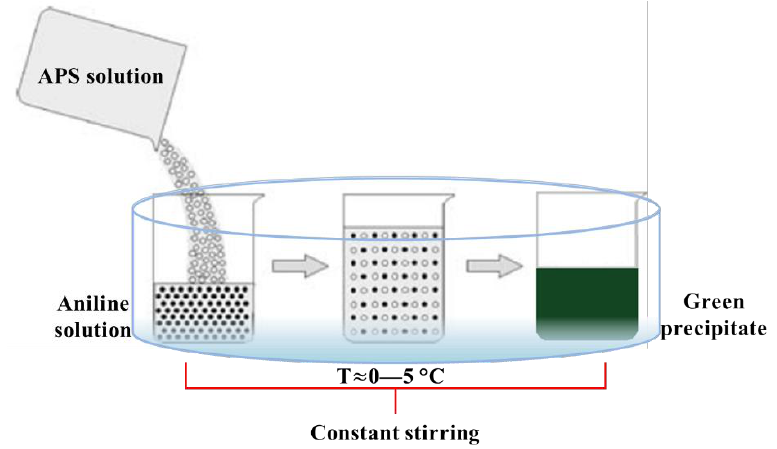
Figure 1. Schematic representation of PANI synthesis by rapid mixing oxidative polymerization of aniline.